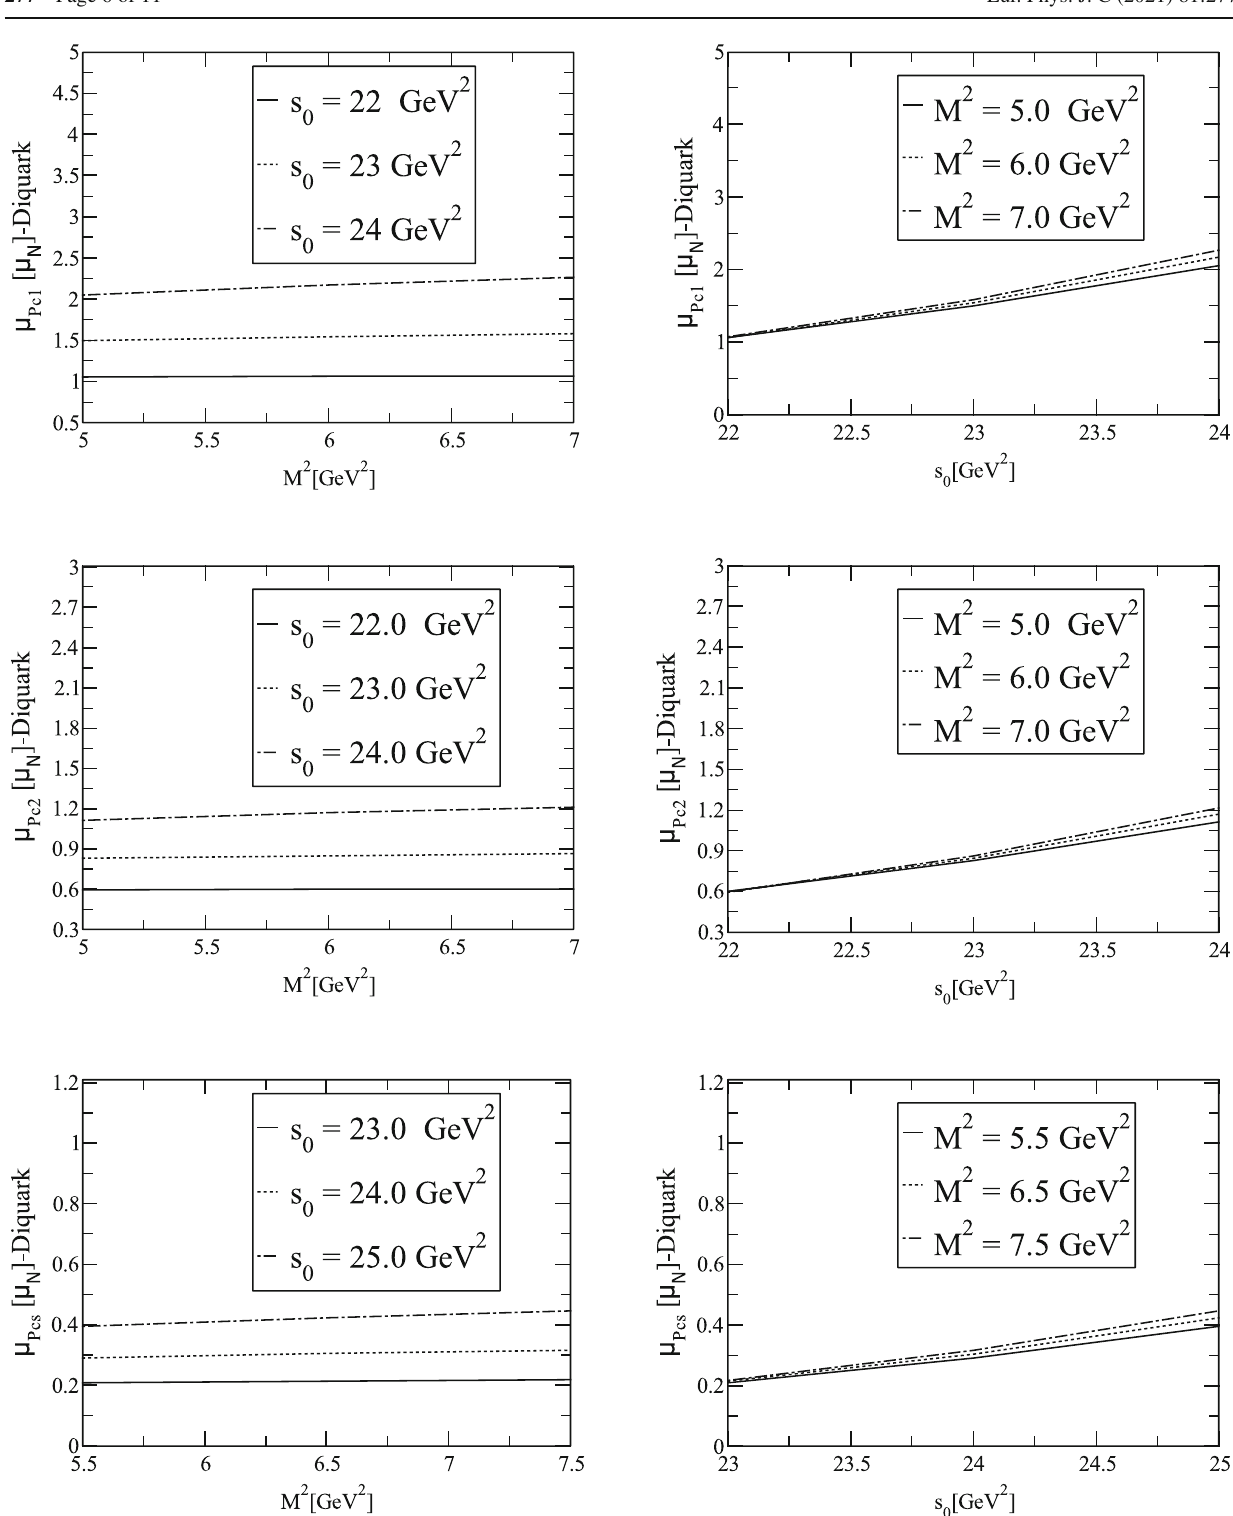
Fig. 1 Variations of the magnetic dipole moments of μ P depend on two auxiliary parameters: Borel mass parameter M 2 and continuum threshold s 0 . According to the philoso-